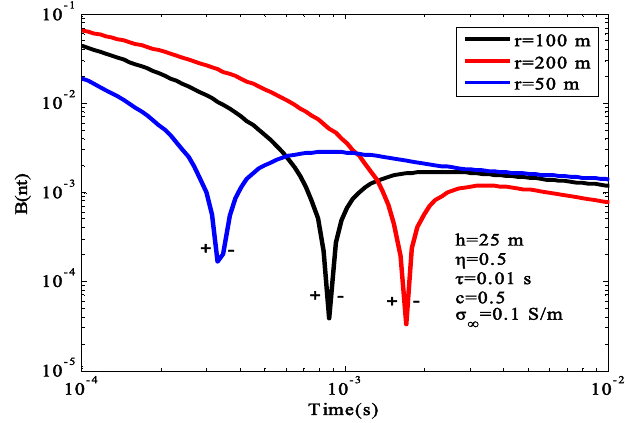
Figure 13. The response curves under different emission source lengths.